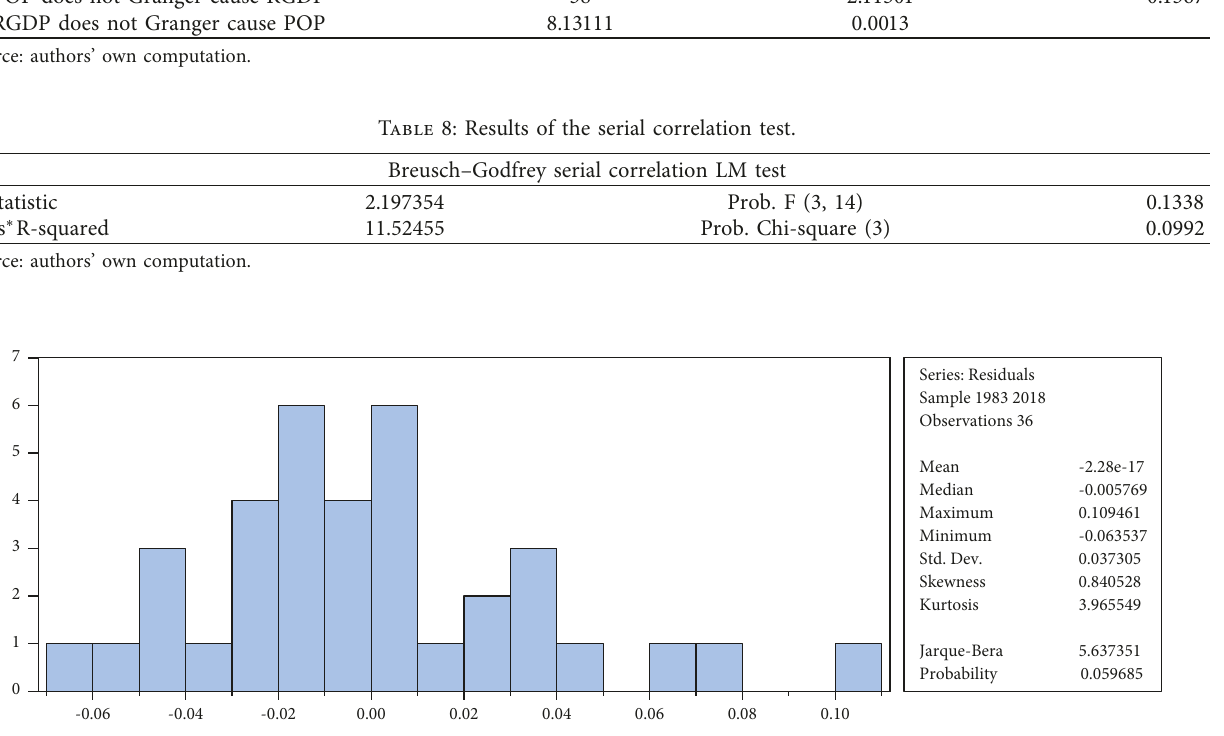
Figure 4: Results of the normality test. Source: authors’ own computation.